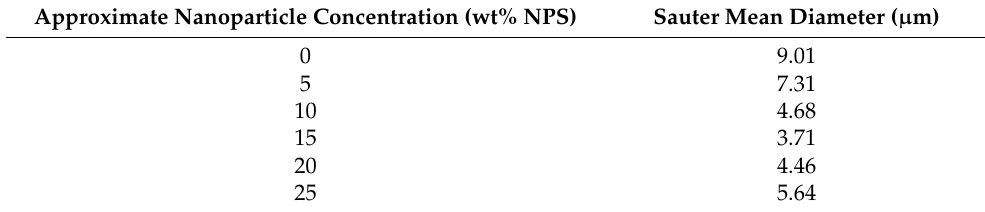
Table 4. Sauter mean diameters of O/W emulsions thickened with starch nanoparticles. The oil concentration is fixed at approximately 65 wt%.